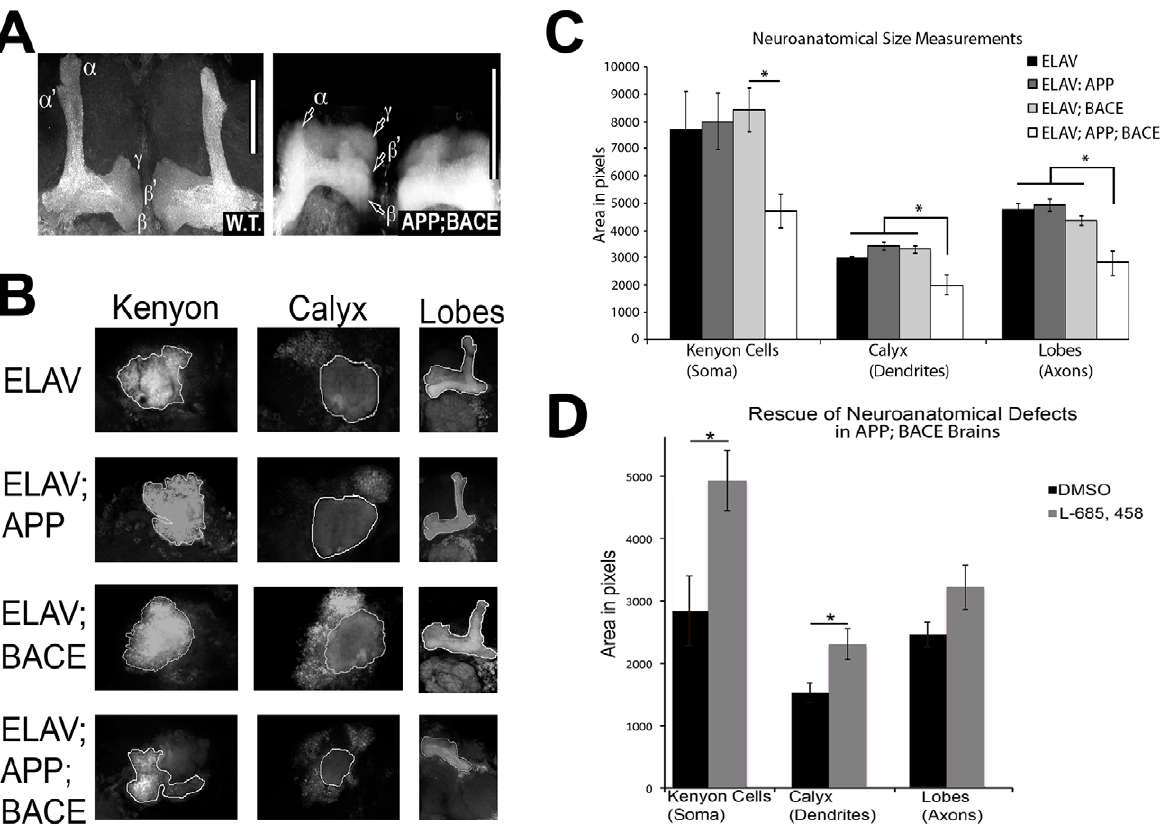
Figure 3. Defects in AD fly neuroanatomy. A ) Mushroom body from elav-CD8-GFP ; + ; + heterozygous fly brain (left) displays normal axonal lobes. The same region in elav-CD8-GFP ; APP ; BACE heterozygous fly brain (right) displays significantly altered axonal lobes. These lobes are labeled. Note the complete loss of a 9 lobe in elav-CD8-GFP ; APP ; BACE heterozygous fly brain. Scale bars indicate 50 m m in both panels. B ) Examples of Kenyon cell (KC) substructures measured in the indicated genotypes. Kenyon indicates KC cell soma. Calyx indicates KC dendritic field. Lobes indicate KC axonal field. C ) Neuroanatomical surface area measurements. Genotypes and substructures indicated. * indicates p , 0.05 , with exact values listed in text. D ) Pharmacological rescue of neuroanatomical surface area decreases in elav-CD8-GFP ; APP ; BACE heterozygous fly brains. Treatments indicated. * indicates p , 0.05 , ANOVA analysis with exact values listed in text. Error bars represent standard error in each case.